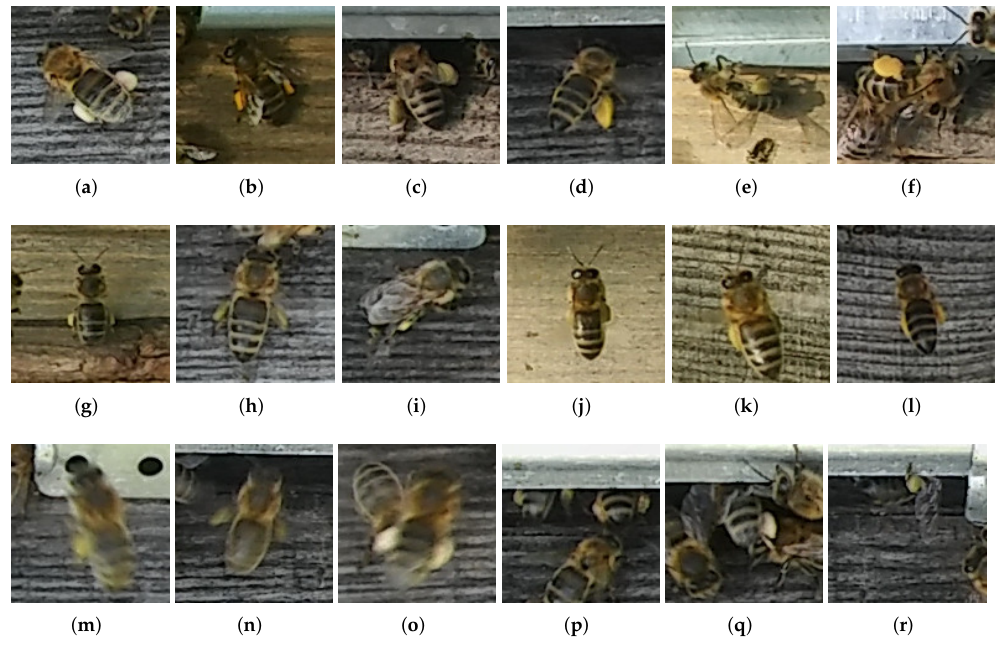
Figure 4. Bees at the entrance of the beehive: normal case with a grain pair ( a – c ), a single pollen grain ( d – f ), tiny grains ( g – i ), nestled grains ( j – l ), blurred grains ( m – o ), and partially obscured by the gate ( p – r